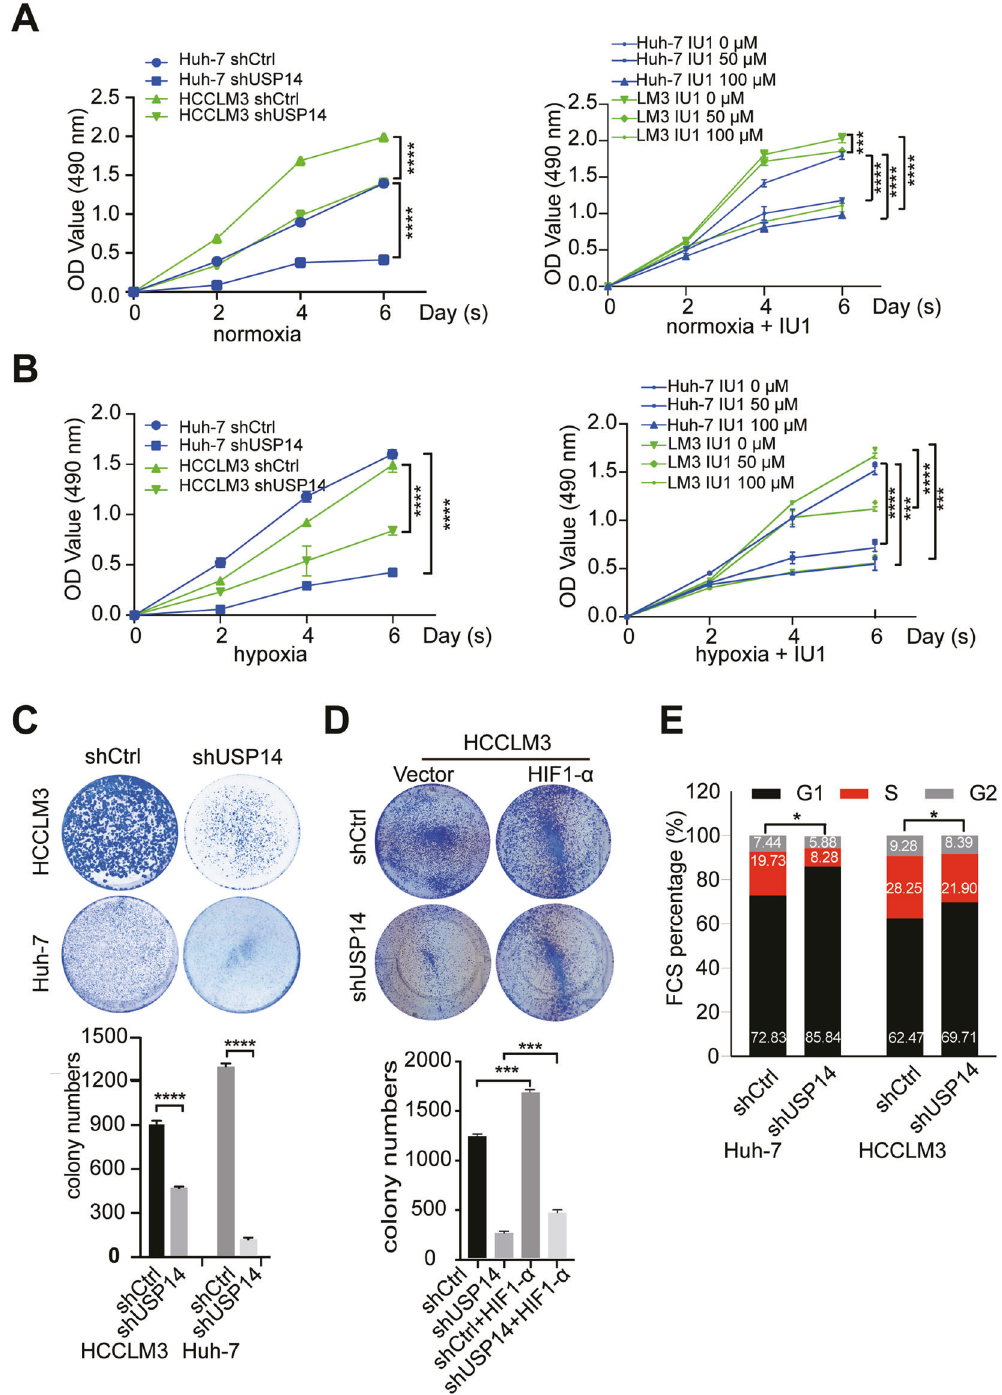
Fig. 4 USP14 increases cell proliferation in HCC cells. A , B The MTS assay was conducted to detect the proliferation of USP14 knockdown and IU1 treated HCC cells in normoxic condition ( A ) and CoCl2 treatment to mimic hypoxia condition ( B ). C Colony formation assay indicated the effects of USP14 on cell growth in HCCLM3 and Huh-7 cells. D Effects of HIF1- α on the proliferation inhibition induced by USP14 knockdown in HCCLM3 cells as illustrated by colony formation assay. E Cell-cycle analysis by fl ow cytometry for HCC cells with knockdown of USP14 (shUSP14). * P < 0.05; ** P < 0.01; *** P < 0.001; **** P < 0.0001; ns = no signi fi cells [22, 23]. We thus turned to examine the effects of USP14 on angiogenesis, and survival of cells [20]. In the hypoxic condition, migratory and invasive behaviors of HCC cells. Firstly, cell HIF-1 α protein is accumulated and induces the activity of its migration and invasion in Huh-7 cells were markedly inhibited downstream vascular endothelial growth factor (VEGF) genes, under normoxia conditions by IU1 supplementation at concentra- thereby promoting VM formation [21]. HIF-1 α was reported to tions of 50 and 100 μ M (Fig. 5A). Transwell assay demonstrated induce vasculogenic mimicry formation in several human cancer